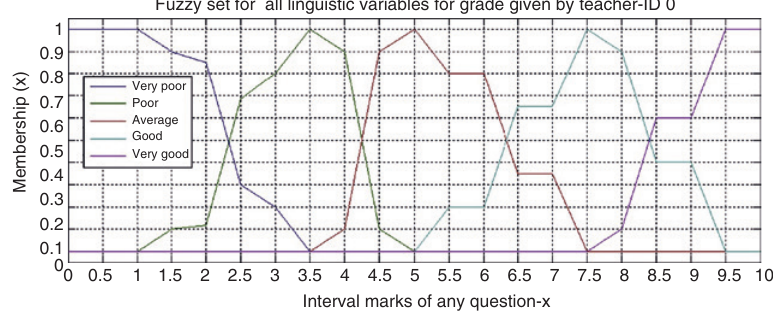
Figure 6: Resultant Aggregated Fuzzy Sets Representing Experts’ Satisfaction Levels.